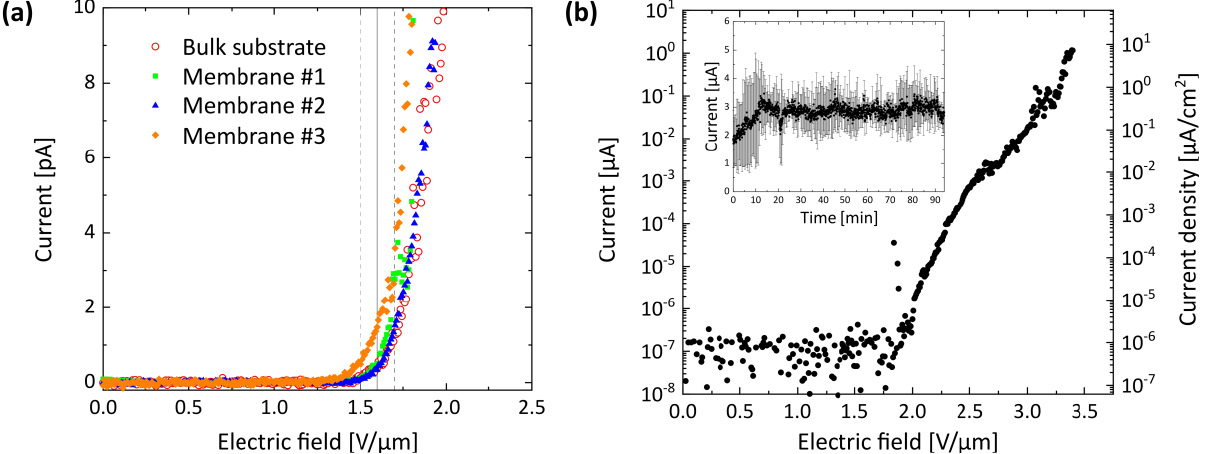
Figure 5. FE properties of ZnO NWs grown on free-standing membranes with porSiO 2 . ( a ) A mean onset field of (1.6 ± 0.1) V/ µ m was found for the three samples with ZnO NWs on membranes as well as for one ZnO emitter array on